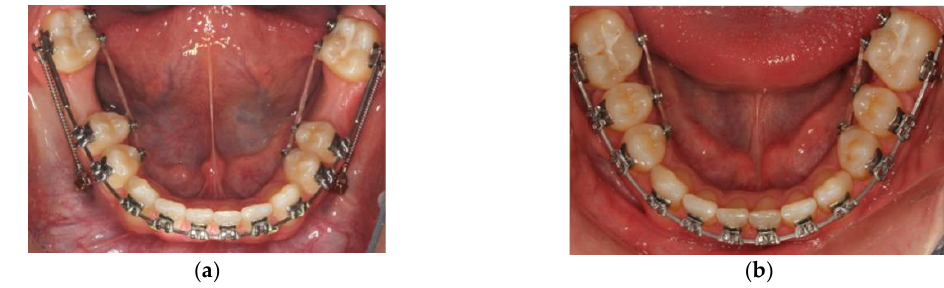
Figure 8. ( a ) Temporary anchorage devices were used to facilitate the space closure of 12 mm of space resulting from the planned extraction of the lower FPMs; ( b ) Spaces were closed after a period of 9 months.